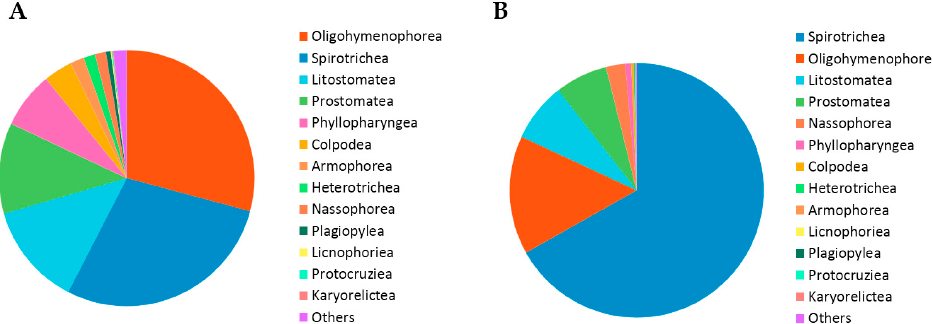
Figure 2. Taxonomic composition of ciliates retrieved from four estuarine sampling stations. Relative abundance of ( A ) amplicon sequence variants (ASVs) and ( B ) read in different ciliate classes.